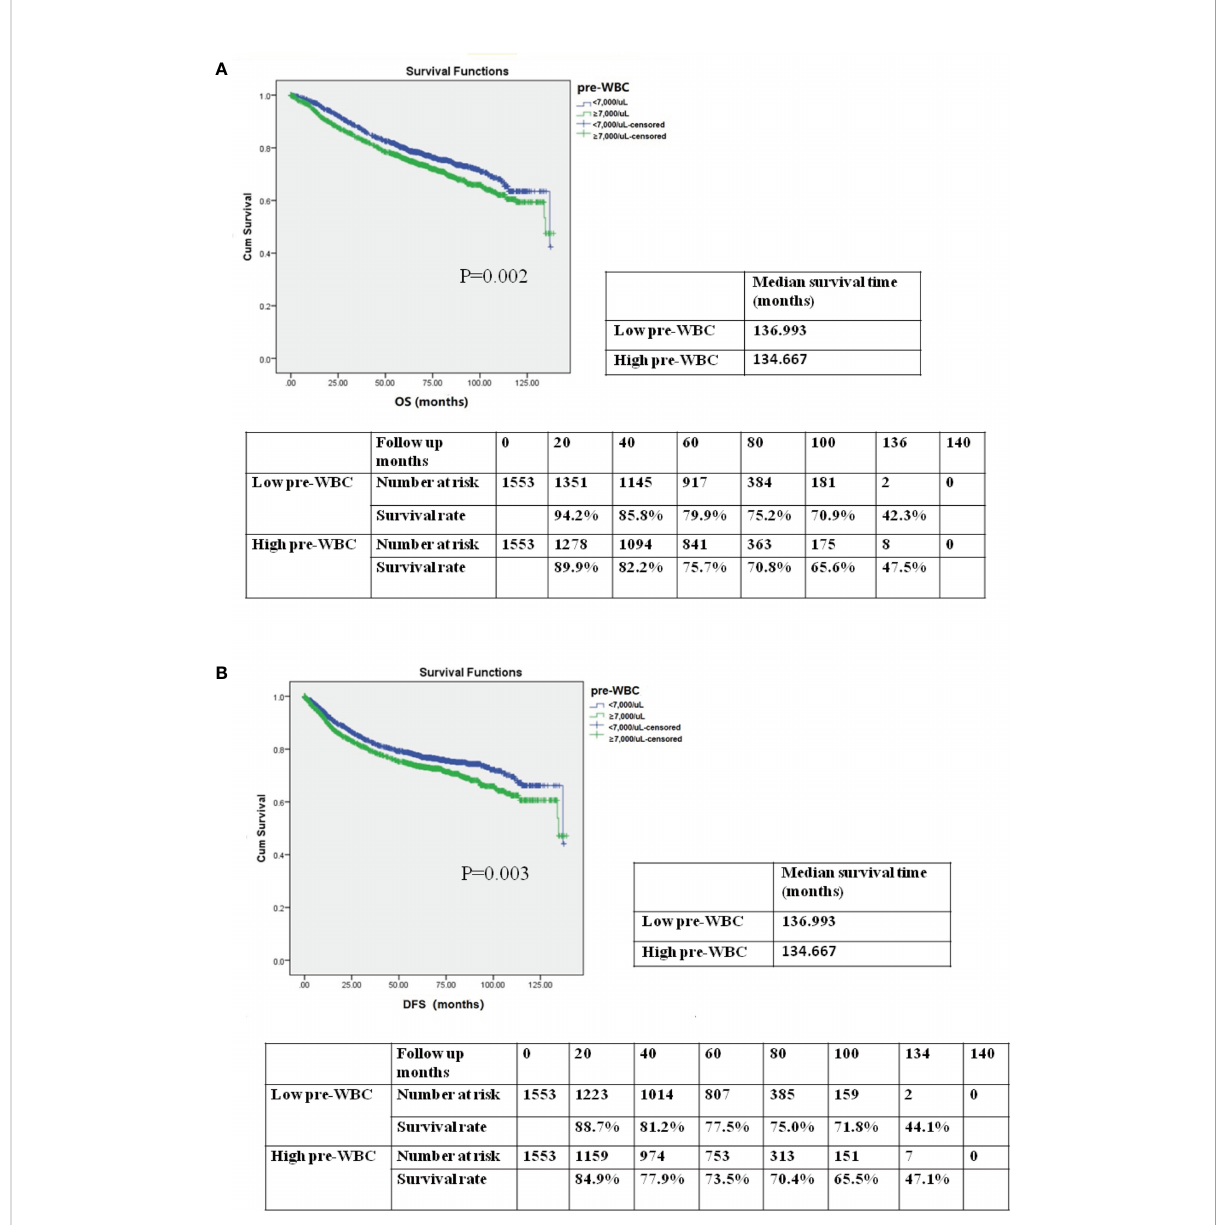
FIGURE 3 (A) Kaplan – Meier survival curve for overall survival (OS) according to preoperative WBC (pre-WBC) in the propensity score-matched cohort. The OS rates, median survival time, and number at risk are shown. (B) Kaplan – Meier survival curve for disease-free survival (DFS) according to preoperative WBC (pre-WBC) in the propensity score-matched cohort. The DFS rates, median survival time, and number at risk are shown. Signi fi cance with P <